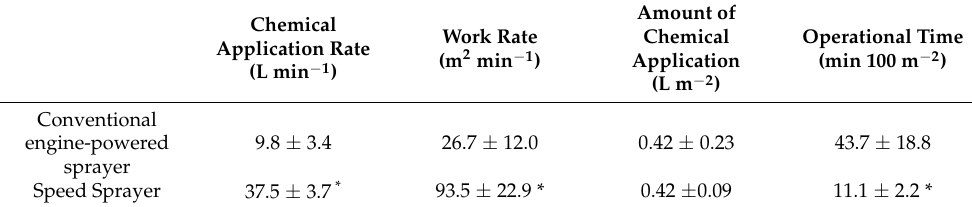
Table 2. Performance of conventional and speed sprayers.